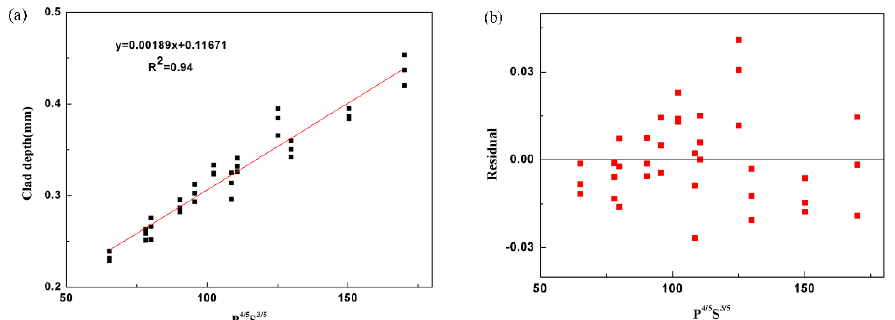
Figure 7. ( a ) The relationship between clad depth and the two processing parameters ( P and S ). ( b ) Residuals.